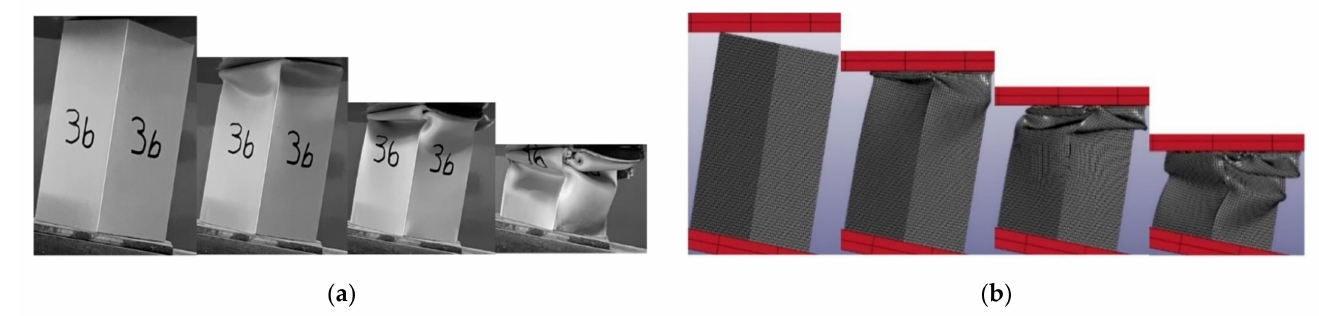
Figure 13. Plastic deformation progress of 10 ◦ crushing angle for cornered oblique impact.